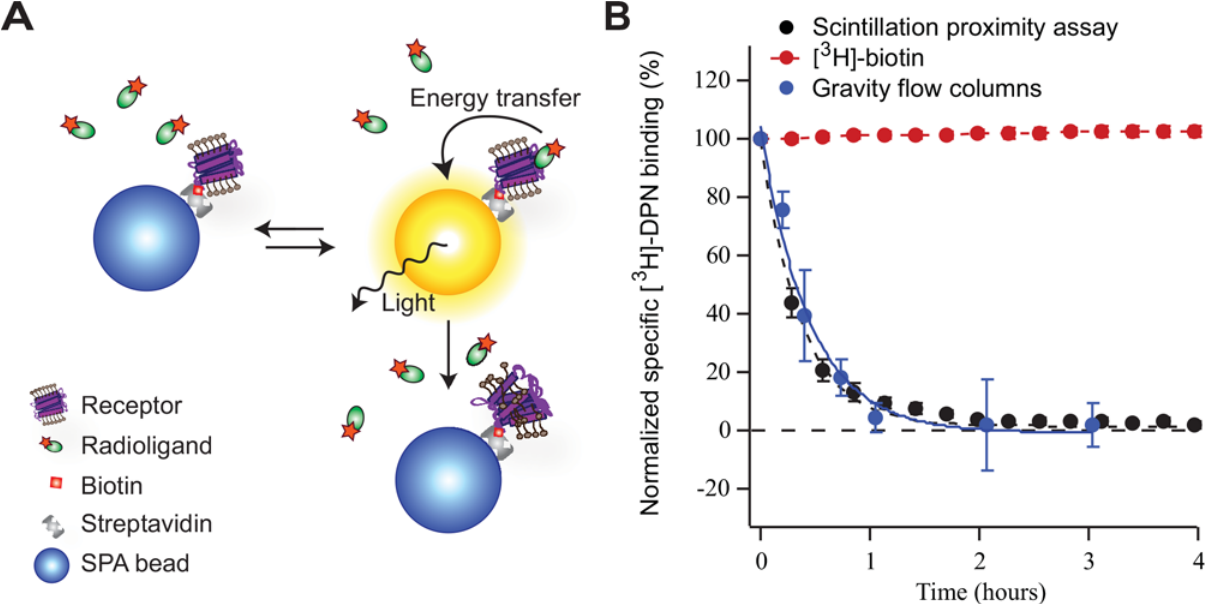
Fig 1. Principle of time-resolved Scintillation Proximity Assay (SPA) to quantify stability of high-affinity radio-ligand binding to GPCRs. A) Receptors are immobilized on the SPA beads. When radioligands bind to immobilized receptors, energy from the radioisotope decay is efficiently transferred to the scintillator contained in the beads, thus generating a detectable light signal. If the buffer, including detergent, causes the loss of receptor affinity to radiolabeled ligand, the signal will start to decrease irreversibly. The decay of high-affinity ligand binding to receptors can be measured when the same assay is counted repeatedly over time. B) Comparison of desalting gravity flow separation columns (blue circles) and SPA (black circles) to measure decrease in binding of [ 3 H]-DPN to KOR over time at room temperature. KOR was solubilized in 1%/0.2% DDM/CHS (w/v) and diluted in the assay to 0.1%/0.02% DDM/ CHS (w/v). Specific binding was normalized to initial binding. As control of assay stability, the signal of bead-immobilized [ 3 H]-biotin was measured in parallel (red circles). Error bars are standard error of the mean from four (gravity flow columns) or three (SPA) independent experiments each done in triplicates. To quantify the stability of ligand binding, data was fitted to an exponential decay function (solid and dashed lines).